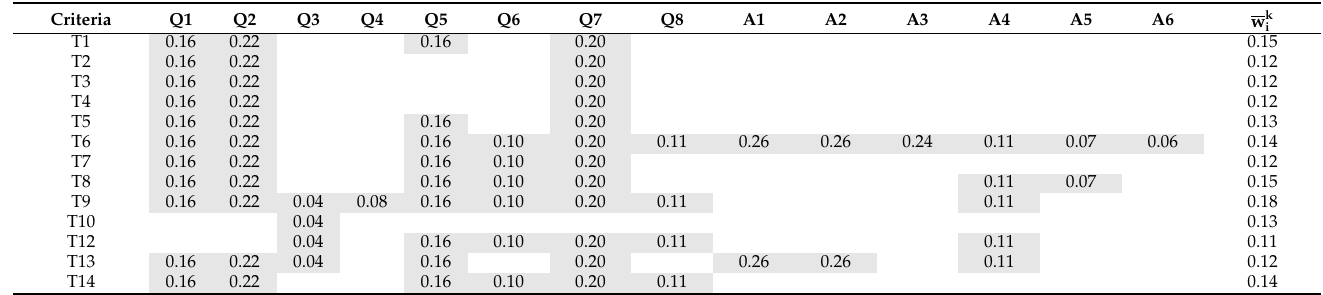
Table 13. Weights for key criteria of PV. Own